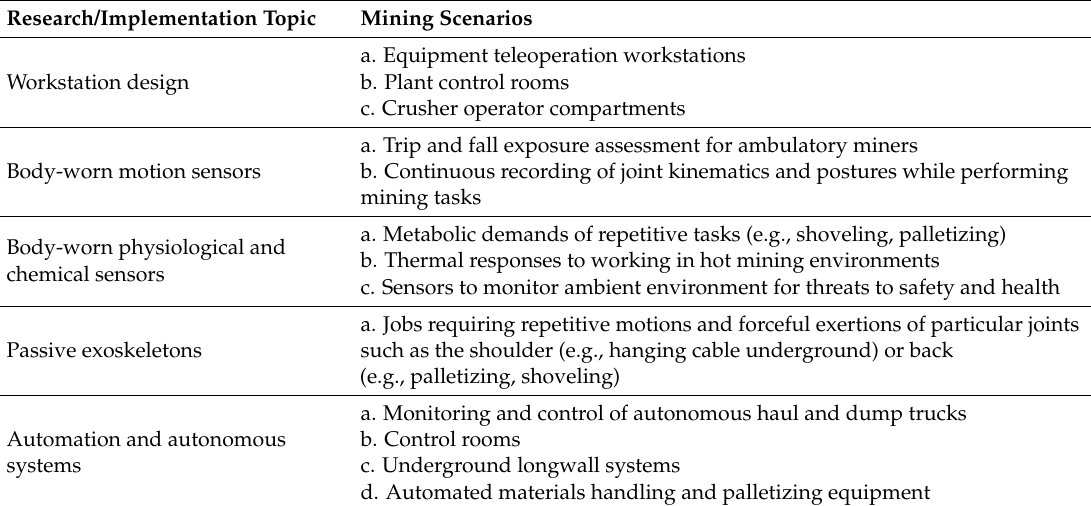
Table 1. Mining scenarios amenable to ergonomics research and